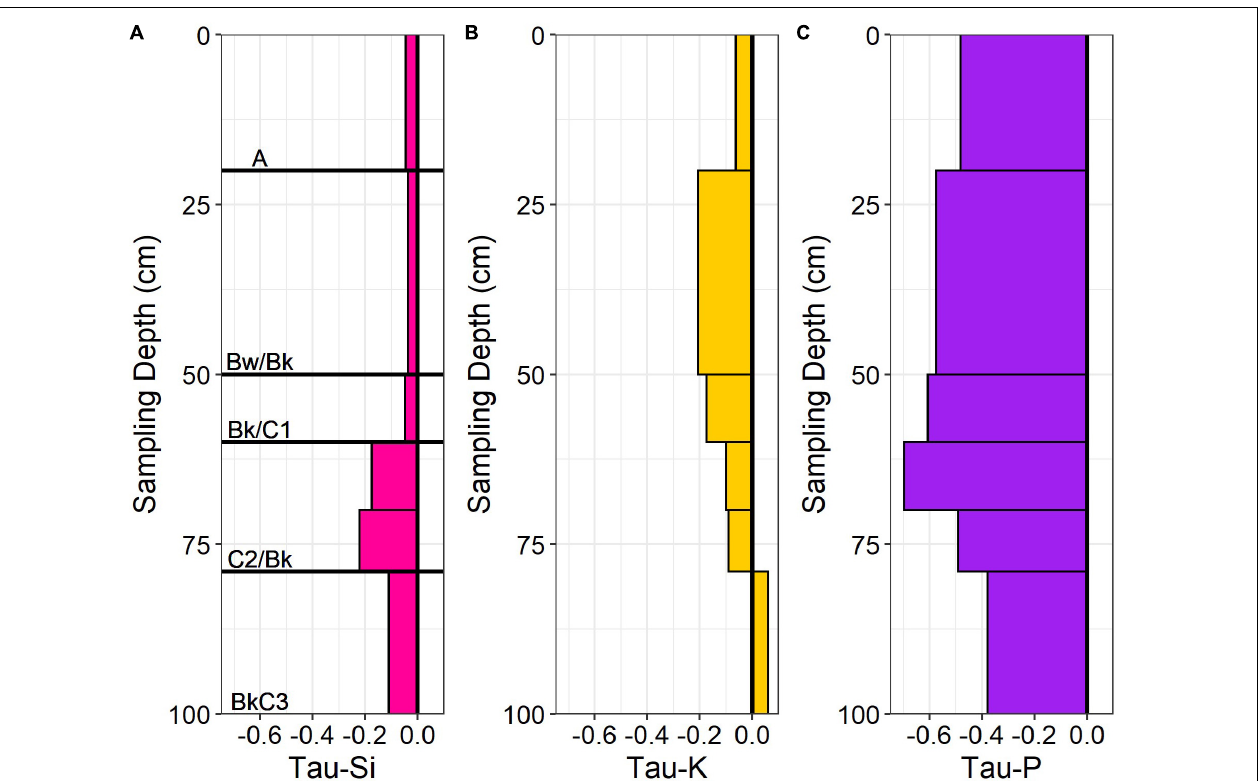
FIGURE 5 | Geochemical mass balance (Tau) profiles of (A) Si, (B) K, and (C) P using Ti as the reference element for the ridgecrest soil (0–100 cm). The value of 0 indicates no change between parent and soil values, positive values indicate additions ( + ) and negative values indicate losses ( − ). Major horizons identified for the soil indicated on (A)